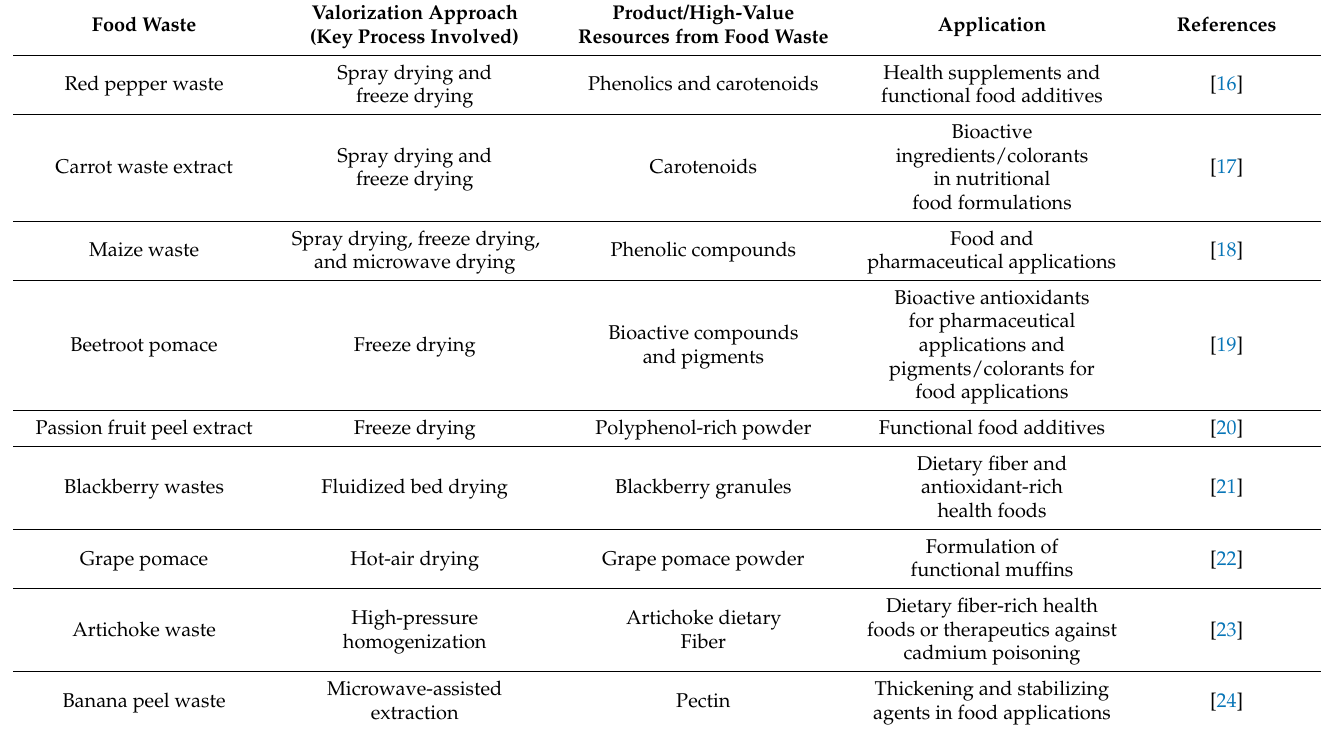
Table 1. Selected examples of resources in food-processing waste streams, valorization approaches, and end